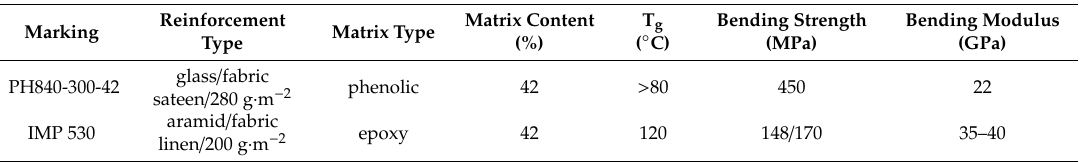
Table 1. Coating material